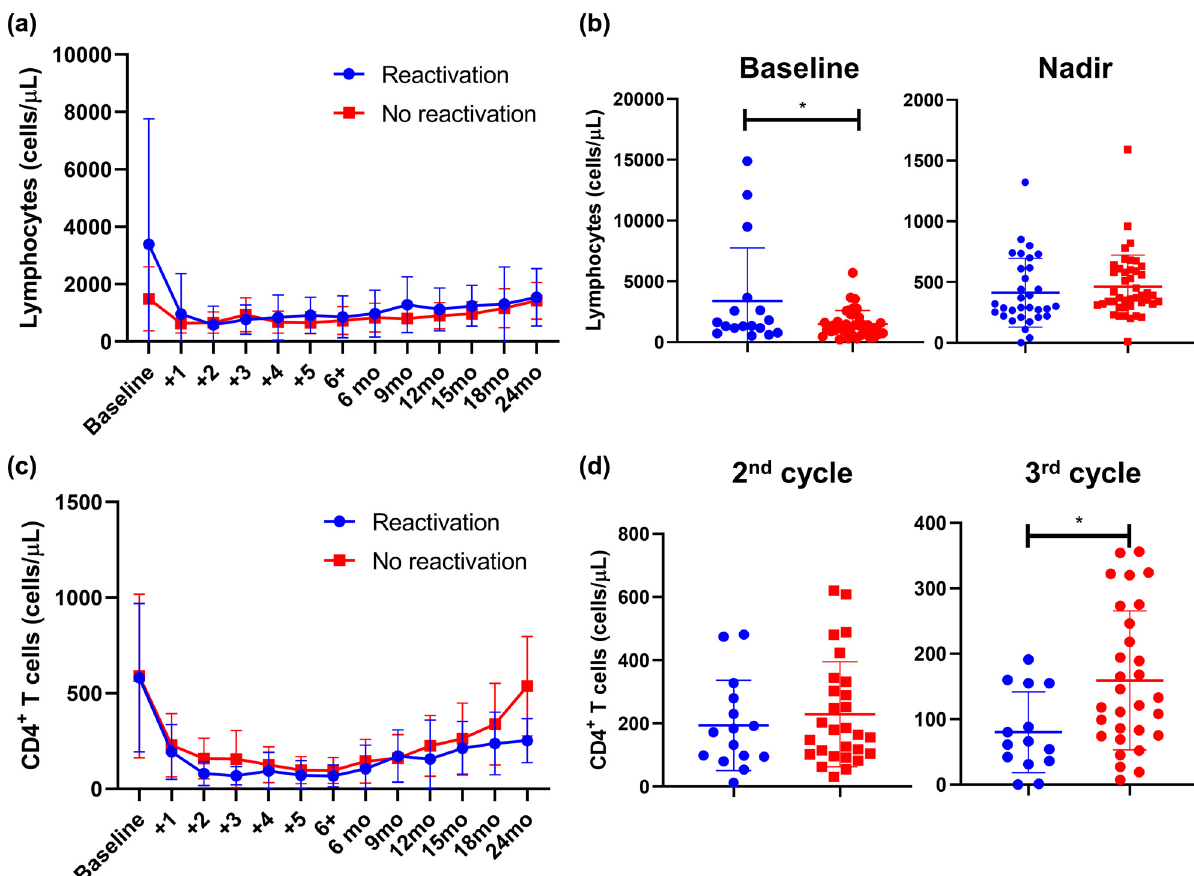
Figure 2: Lymphocyte and CD4 + T cell counts in CMV - reactivated and non - reactivated NHL patients. Patients were divided into two groups: subjects with CMV - reactivation ( blue line or dots ) , and without CMV reactivation ( red line or dots ) ; and ( a ) lymphocyte counts are shown accordingly at baseline, before starting every cycle of bendamustine, and at regular monthly follow - up ( month, mo ) . ( b ) Di ff erences in lymphocyte counts at baseline and at the nadir of CMV reactivation were assessed by unpair t - test between patients who experienced CMV reactivation ( blue dots ) and those who did not have viral reactivation ( blue dots ) . Similarly, CD4 + T cell counts were assessed from baseline through the follow - up ( c ) , and frequencies of CD4 + cells in CMV - reactivated ( blue dots ) and non - reactivated ( red dots ) patients at the second and third cycle of bendamustine ( d ) are displayed. Data are shown as mean ± Standard Deviation ( SD ) . * P <